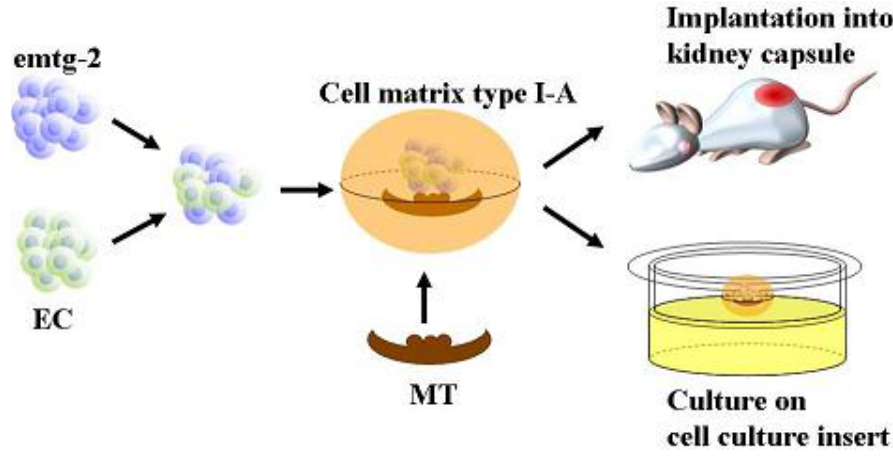
Figure 14. Preparation of artificial tooth